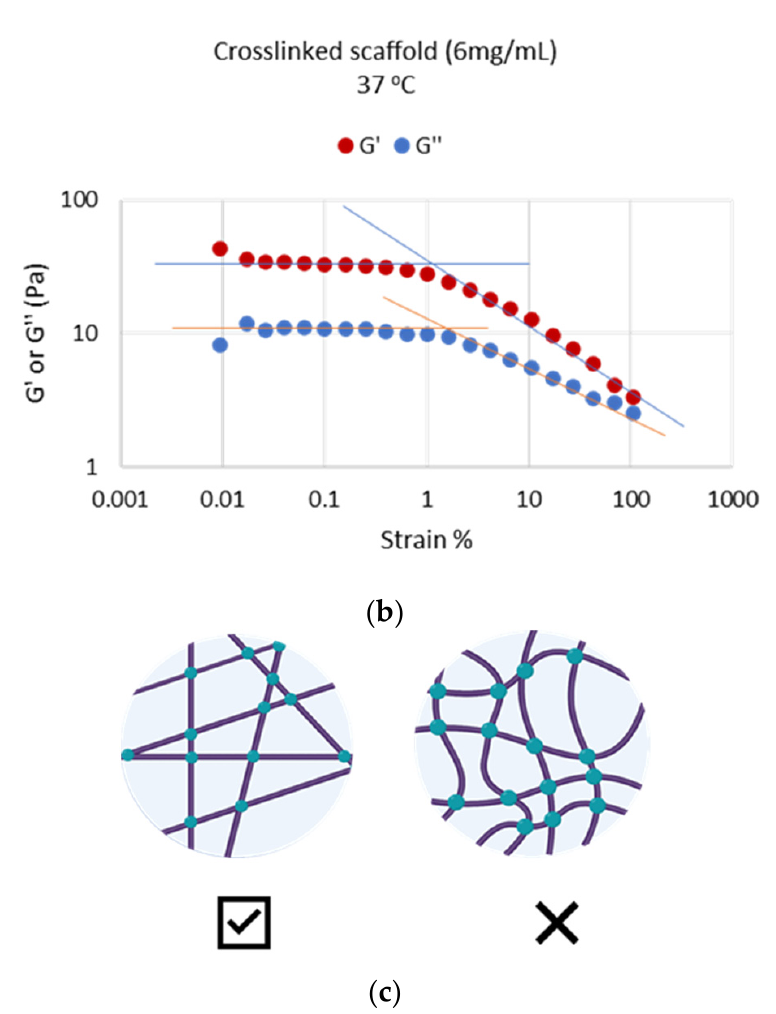
Figure 4. Determination of the Linear Viscoelastic Region of the crosslinked biomaterials. ( a ) Plots of elastic modulus (G ′ ) or viscous modulus (G ″ ) as a function of applied strain (%) in the crosslinked biomaterials (6 mg/mL in DMEM) at 37 °C. “BMP2”: scaffold-BMP2, “without peptides”: scaffold without peptides, “Apr”: April 2022 measurements, “Jul”: July 2022 measurements. ( b ) Plot of G ′ and G ″ as a function of applied strain (%) in the crosslinked biomaterials (6 mg/mL in DMEM) at 37 °C. The G ′ to G ″ ratio indicates the formation of elastic networks. ( c ) Schematic representation of the behavior of the biomaterials at 37 °C in DMEM. The “crosslinked” biomaterials have a small LVR region, indicating that they rather behave as semi-rigid ( a ), rather than fully flexible ( b ), polymers. Created with BioRender.com. All data correspond to different aliquots of the same samples in order to avoid preshearing effects or different sample preparations in order to show reproducibility.